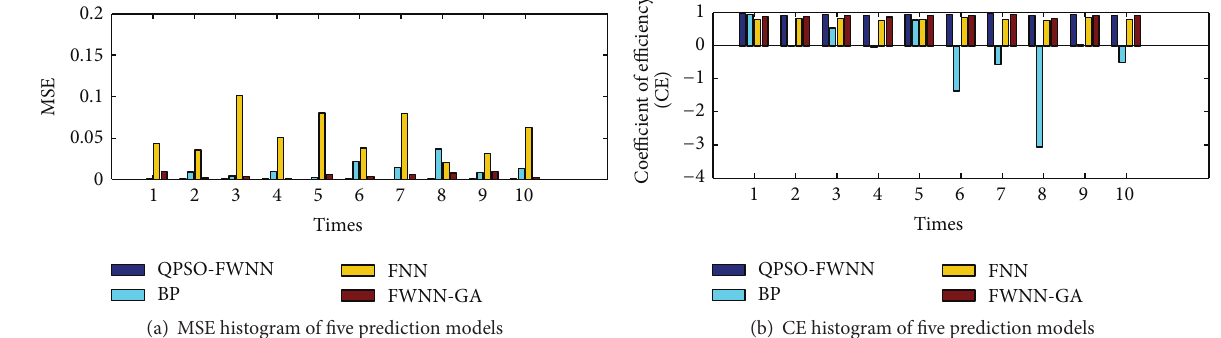
Figure 12: MSE and CE histogram of four prediction